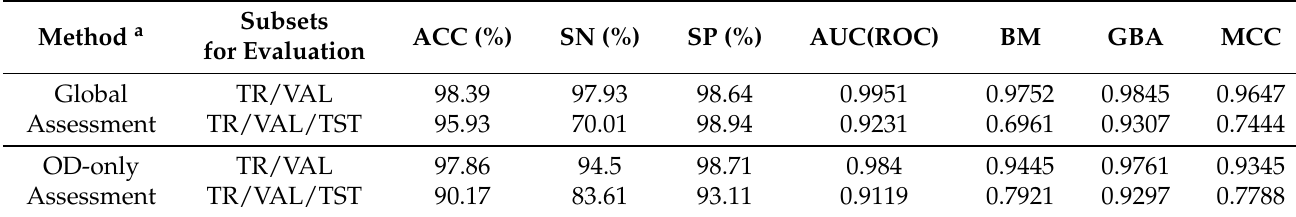
Table 5. Results from Multi-stage ensemble-based CAD system proposed for GON